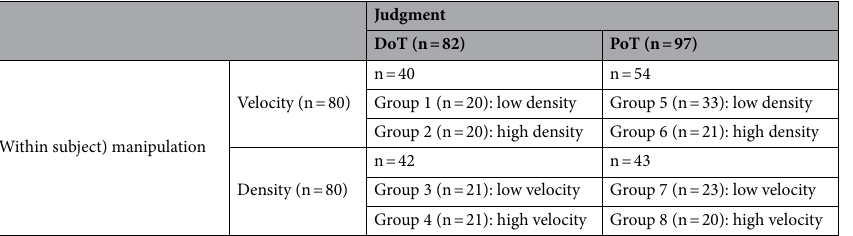
Table 3. Condition combinations of the 8 experimental groups, each containing a minimum of 20 participants. Each group had to provide either DoTJs or PoTJs (columns) and was confronted with changes in one of the two modalities velocity and density (rows), while the other was kept constantly low or high (2nd and 3rd line in each